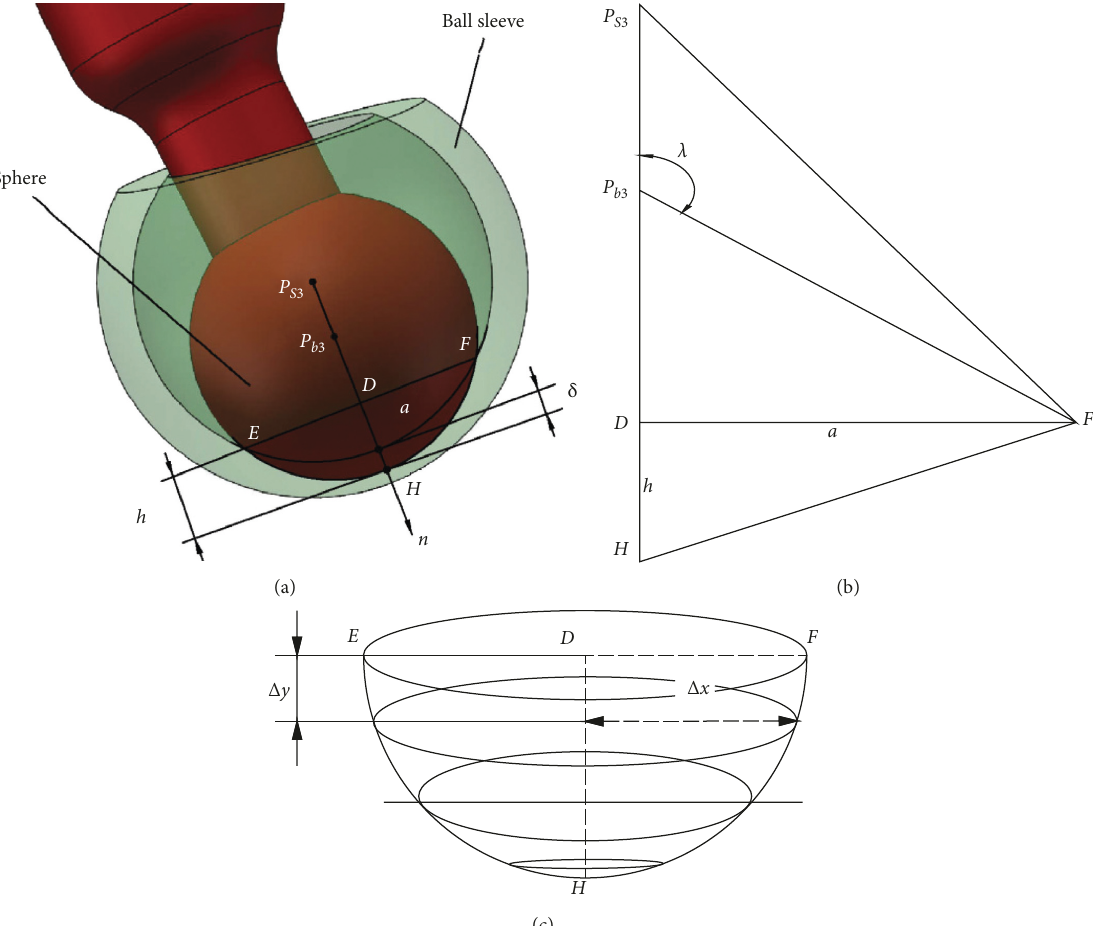
Figure 6: Contact form and geometric relationship of the spherical joint with clearance.